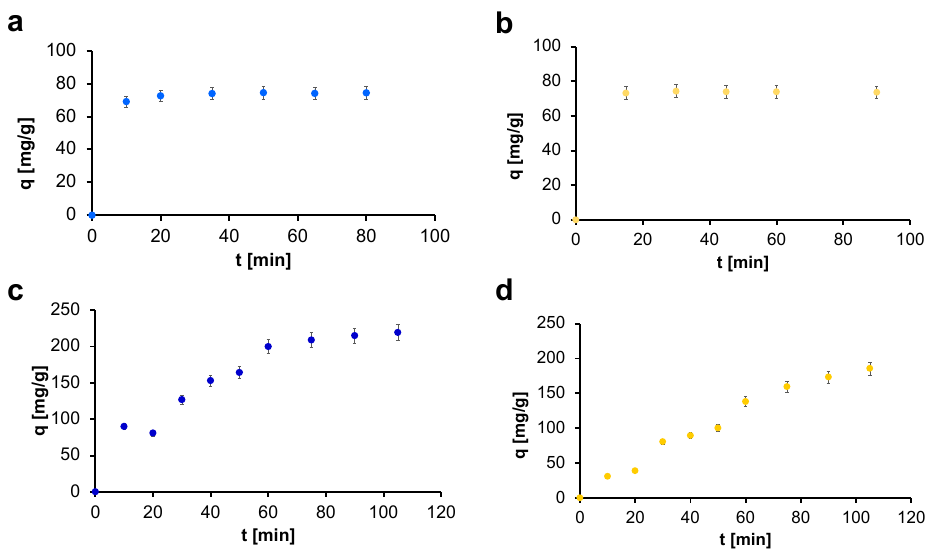
Figure 5. Sorption capacity of GO-CS AG to IC (blue dots) and CBY (yellow dots) in different concentrations: ( a ) IC 100 mg/L, ( b ) CBY 100 mg/L, ( c ) IC 350 mg/L, and ( d ) CBY 350 mg/L.